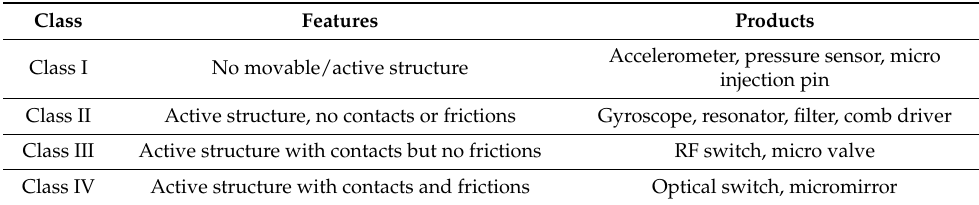
Table 2. Classification of MEMS in reliability research [11].